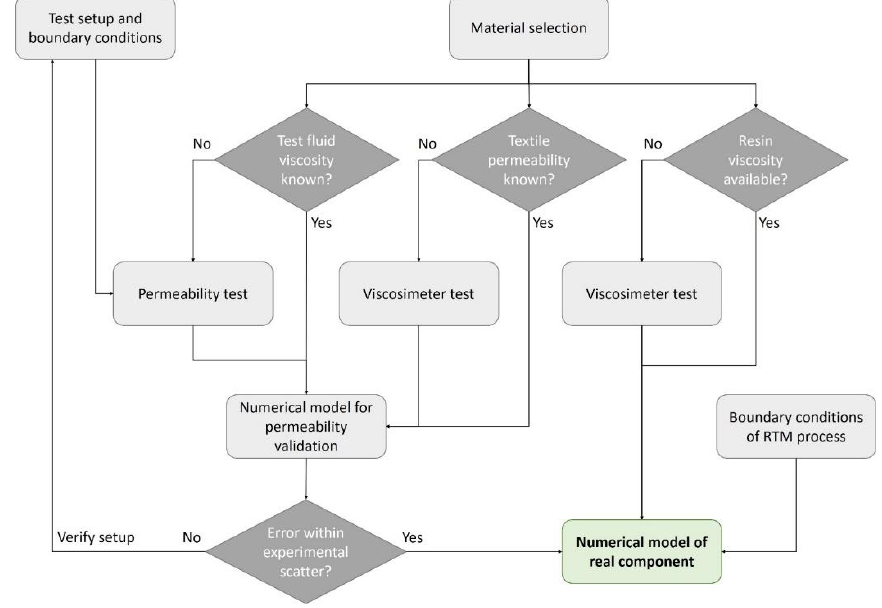
Figure 8. Workflow to model the resin transfer molding (RTM) process of a real component.